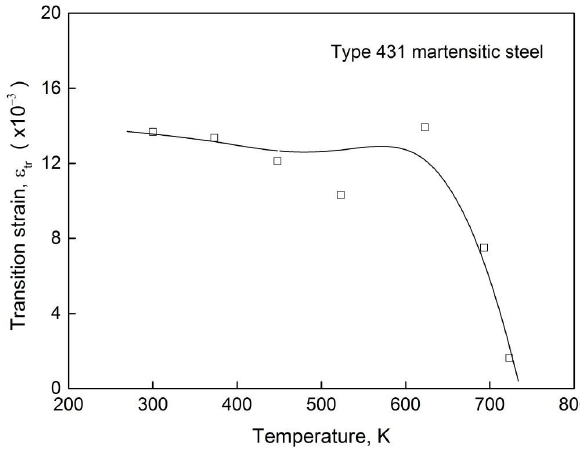
Figure 17: Variation of Ludwigson transition strain ϵ tr with tempera- ture for the AISI 431 steel.